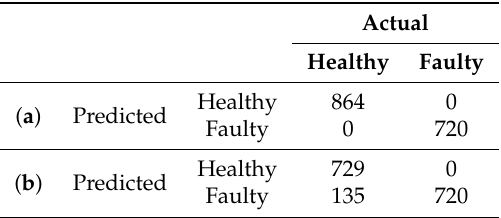
Table 2. Support vector machine (SVM) confusion matrices: ( a ) using both root mean square (RMS) and kurtosis as inputs; and ( b ) using only the RMS.